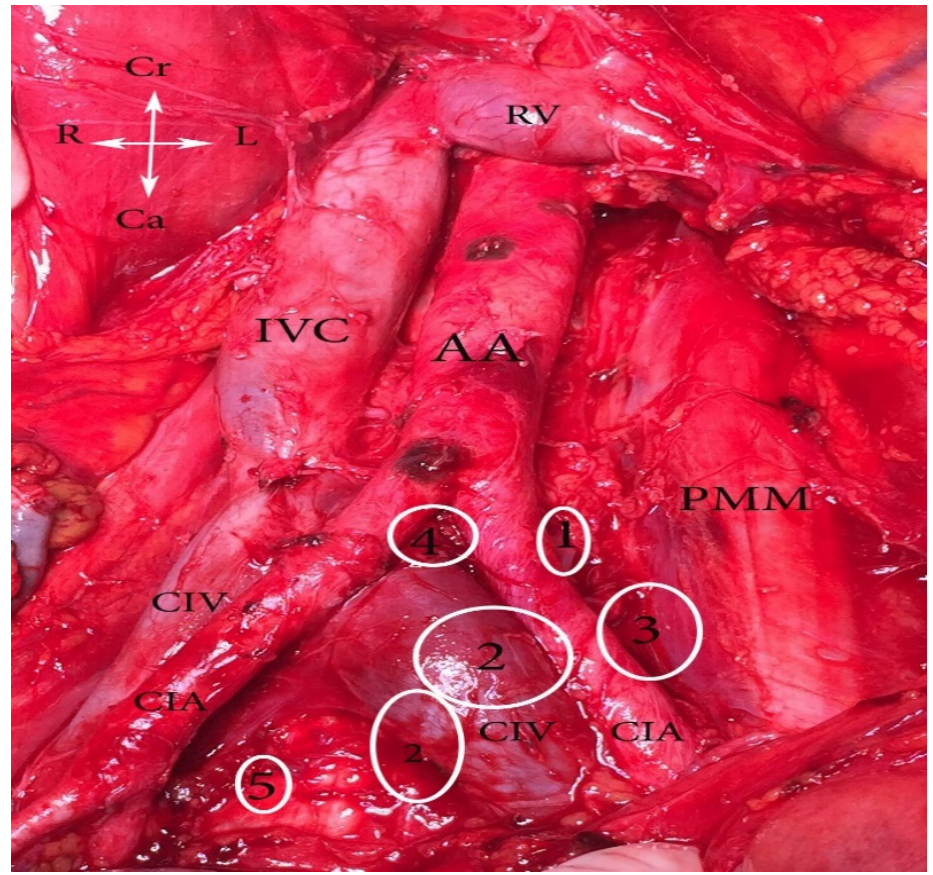
Figure 1. Common iliac lymph nodes classification (open surgery). 1. Lateral—between lateral part of CIV and medial part of psoas major muscle, 2. medial—medial to CIV and CIA, 3. middle—located in the lumbosacral fossa, 4. subaortic—below aortic bifurcation, 5. promontory—at the